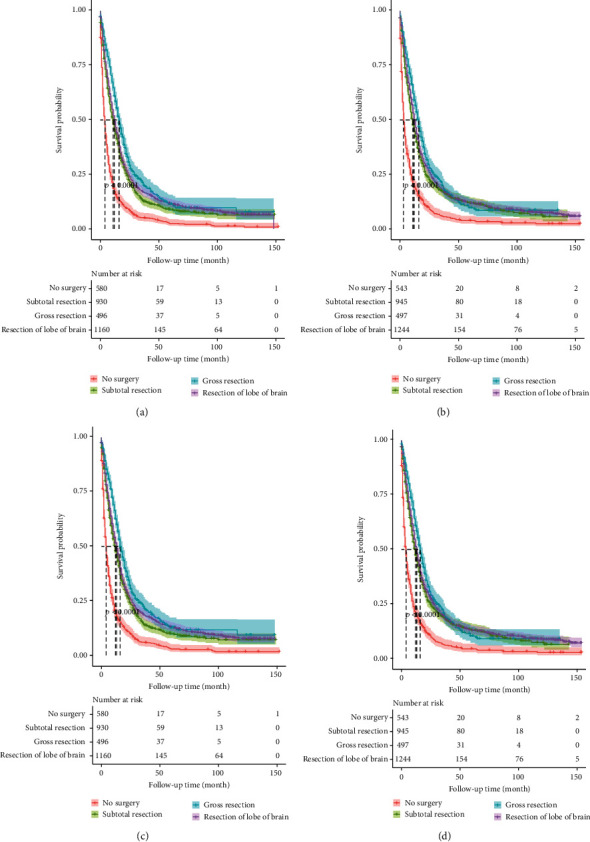
Survival analysis curve for surgical types of the nomograms of training and validation set. Figure (a) is the survival analysis curve of OS in training set. Figure (b) is the survival analysis curve of OS in validation set. Figure (c) is the survival analysis curve of CSS in training set. Figure (d) is the survival analysis curve of CSS in validation set.